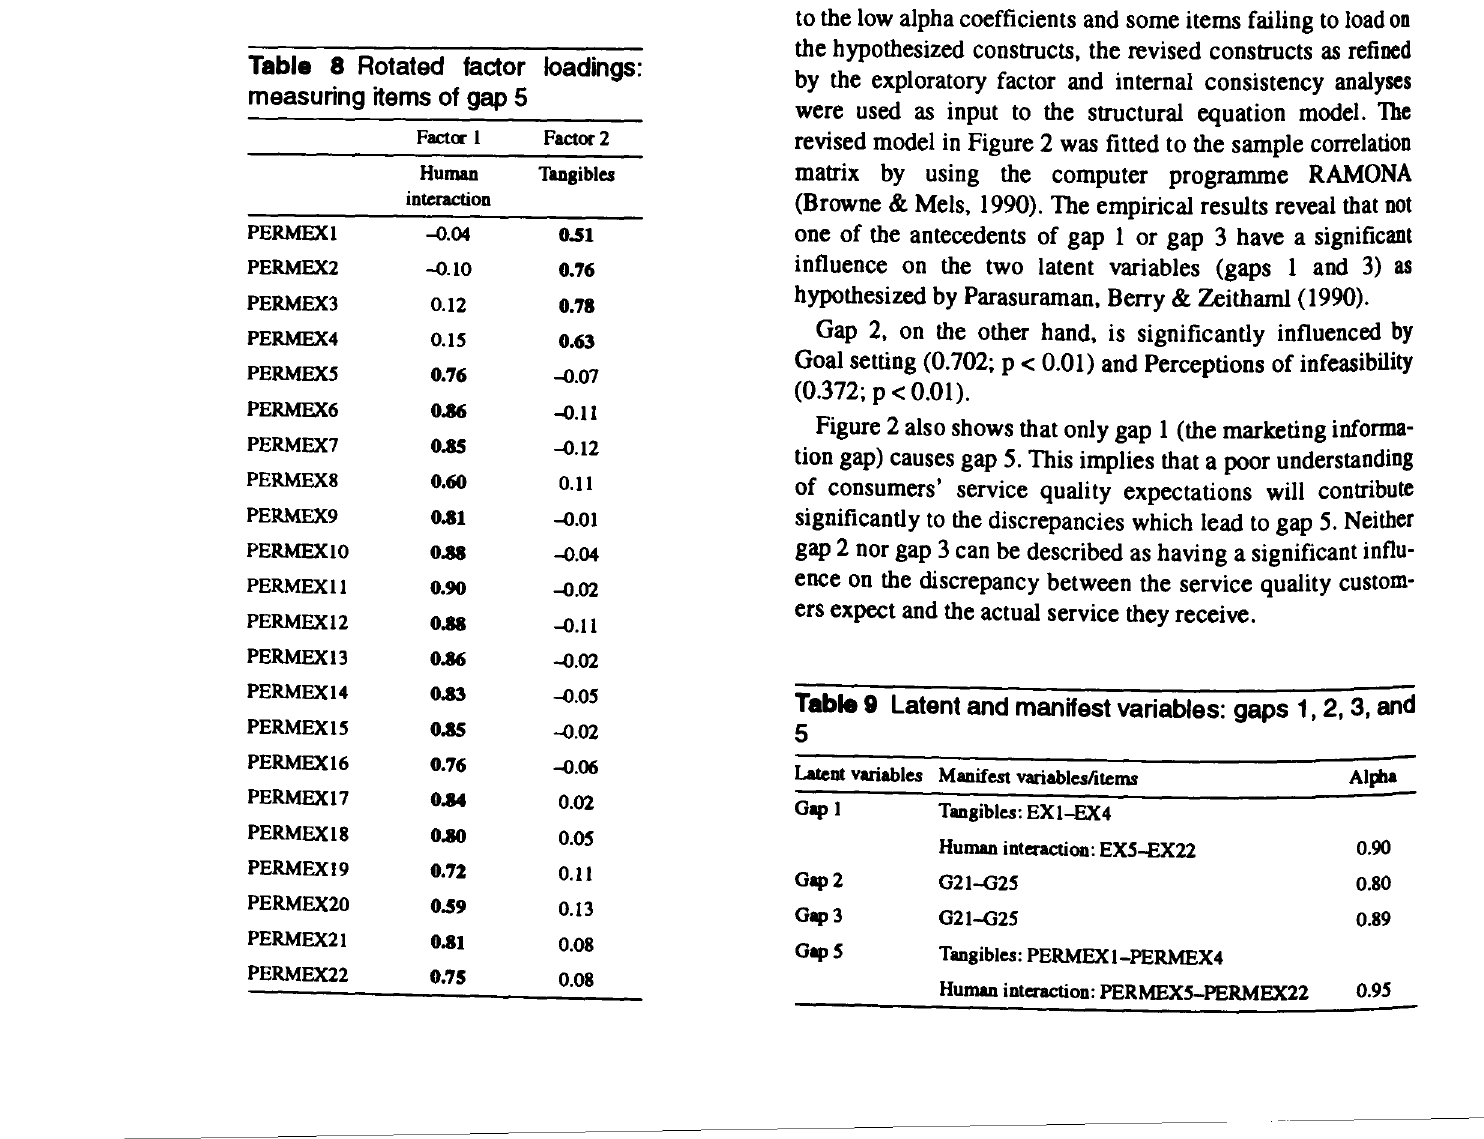
measuring items of gap 5